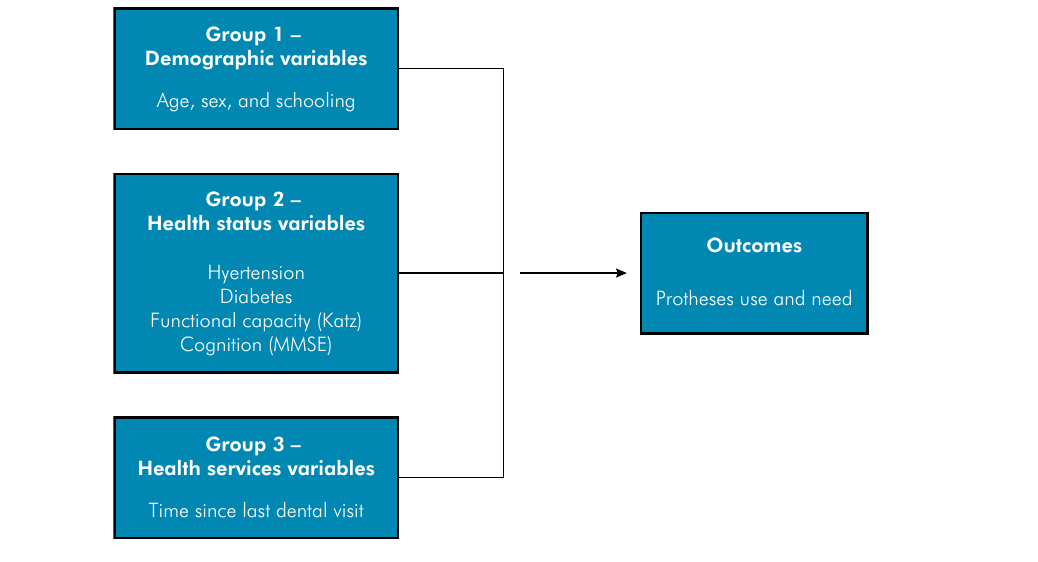
Figure. Outcomes theoretical study